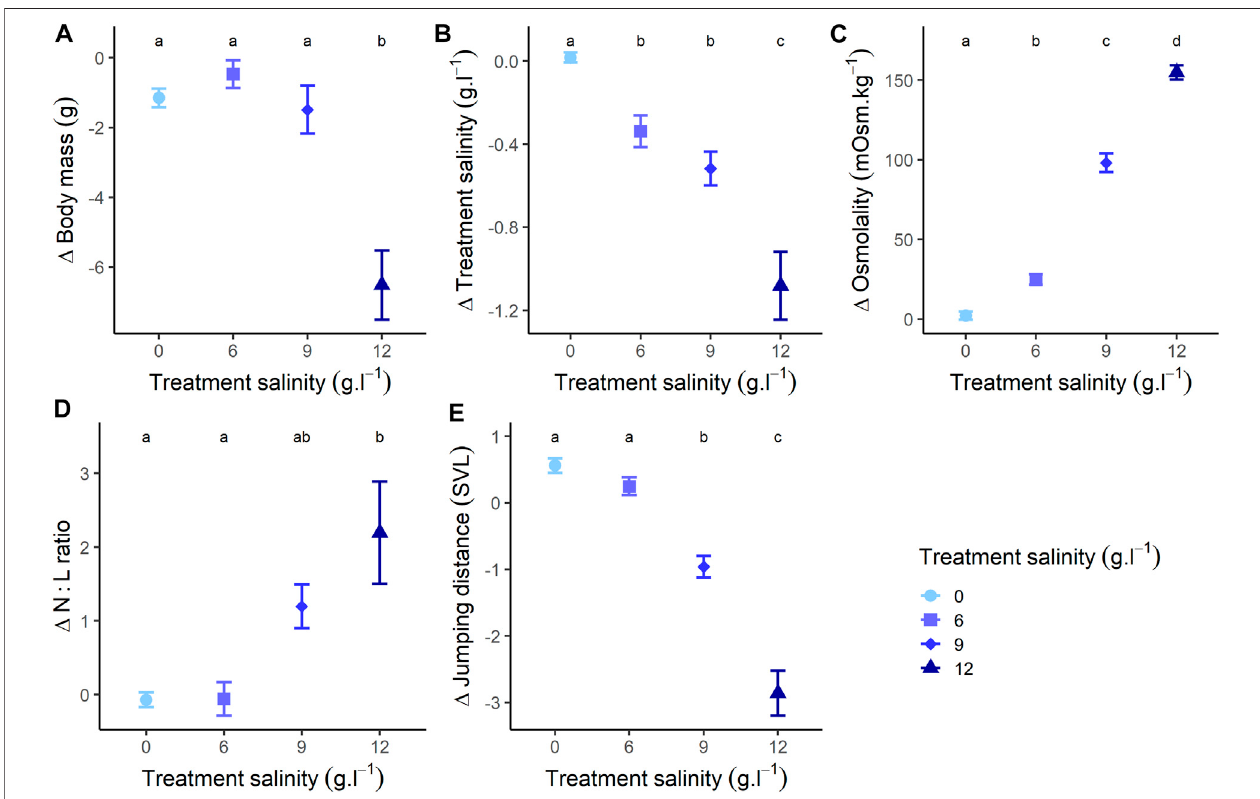
FIGURE 2 | Changes of (A) body mass, (B) salinity (changes in treatment salt concentration during exposure), (C) osmolality, (D) N:L ratio (Neutrophils/ Lymphocytes ratio), and (E) jumping performance (relative to individuals body size: mean distance [mm]/individuals body size [mm]), at the end of the experiment (48 h treatment) compared to the beginning of the experiment. Different letters represent a signi fi cative difference at α = 0.05 for variations during exposure.